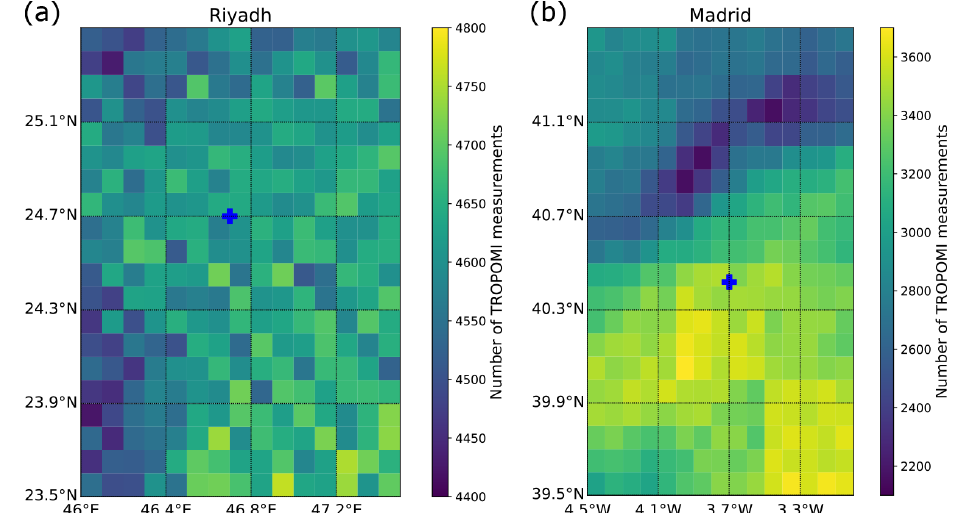
Figure A1. The number of TROPOMI measurements in each 0.1 ◦ grid pixel for Riyadh and Madrid during May 2018–June 2022.